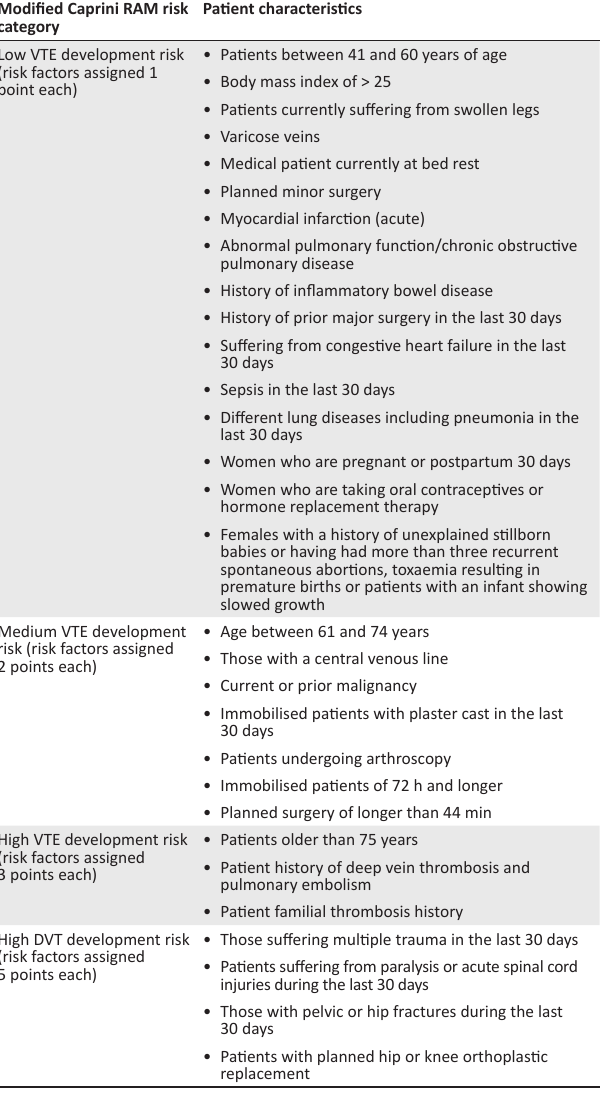
TABLE 1: Risk assessment model from study